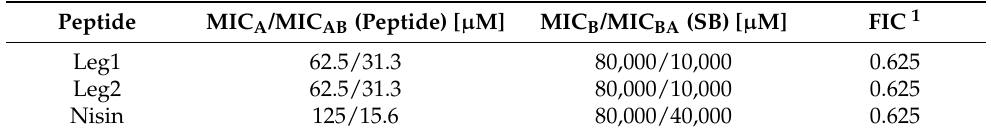
Table 1. Results of the checkerboard assay of Leg1/Leg2/nisin and sodium benzoate (SB) against E. coli displaying MIC A /MIC B (MIC for the peptide or SB), MIC AB /MIC BA (MIC for the combination of peptide and SB) and fractional inhibitory concentration (FIC)